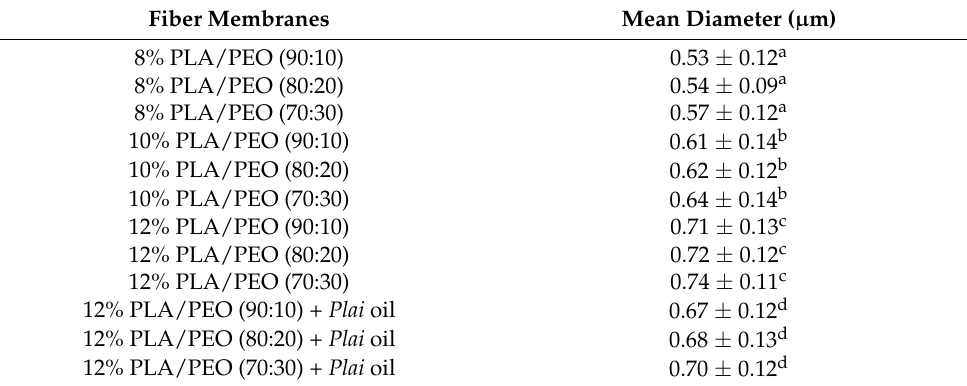
Table 1. Mean fiber diameters of electrospun membranes.